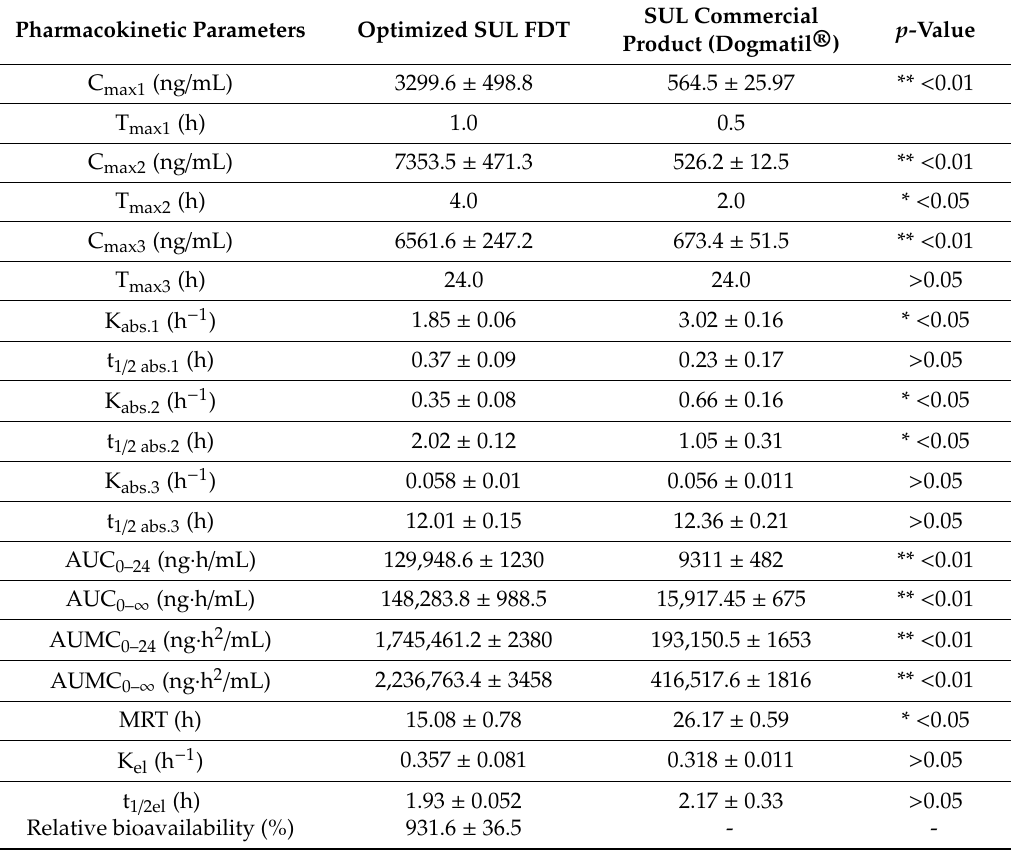
Table 5. Plasma pharmacokinetic parameters of optimized SUL-FDT and SUL commercial product (Dogmatil ® ). Results expressed as mean ± SD ( n =